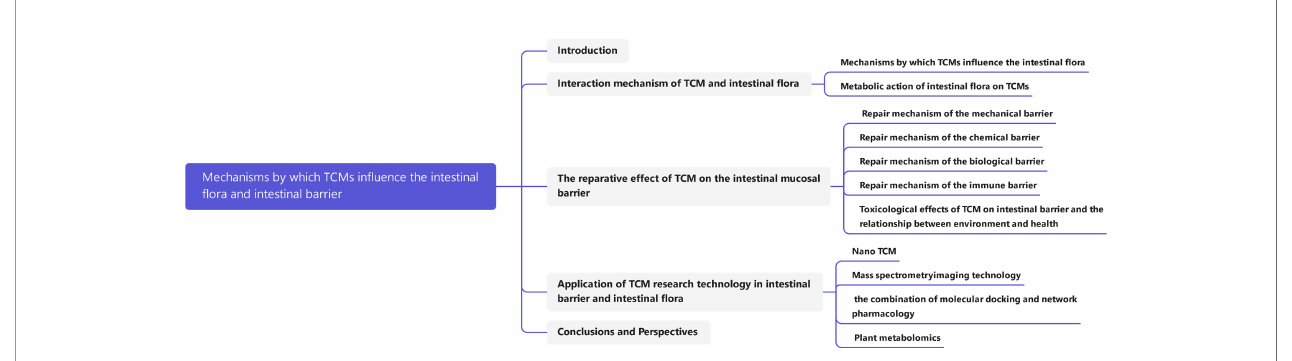
FIGURE 1 | Article Mind